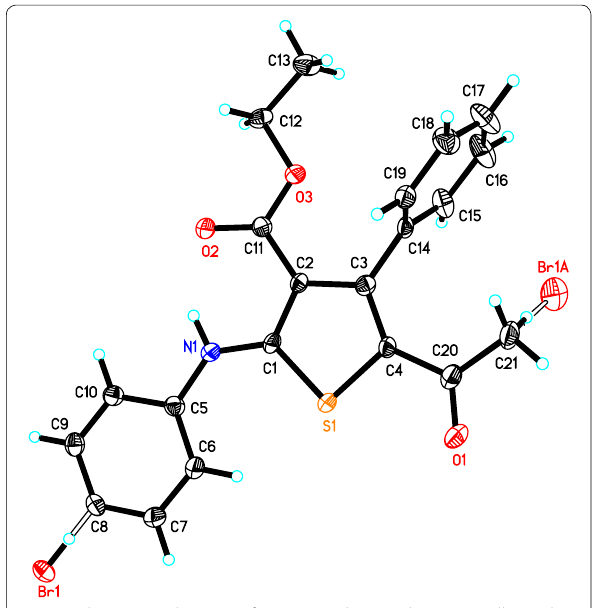
Fig. 2 The ORTEP diagram of compound 2 . Displacement ellipsoids are plotted at the 50% probability level for non‑H atoms showing the two different isomers